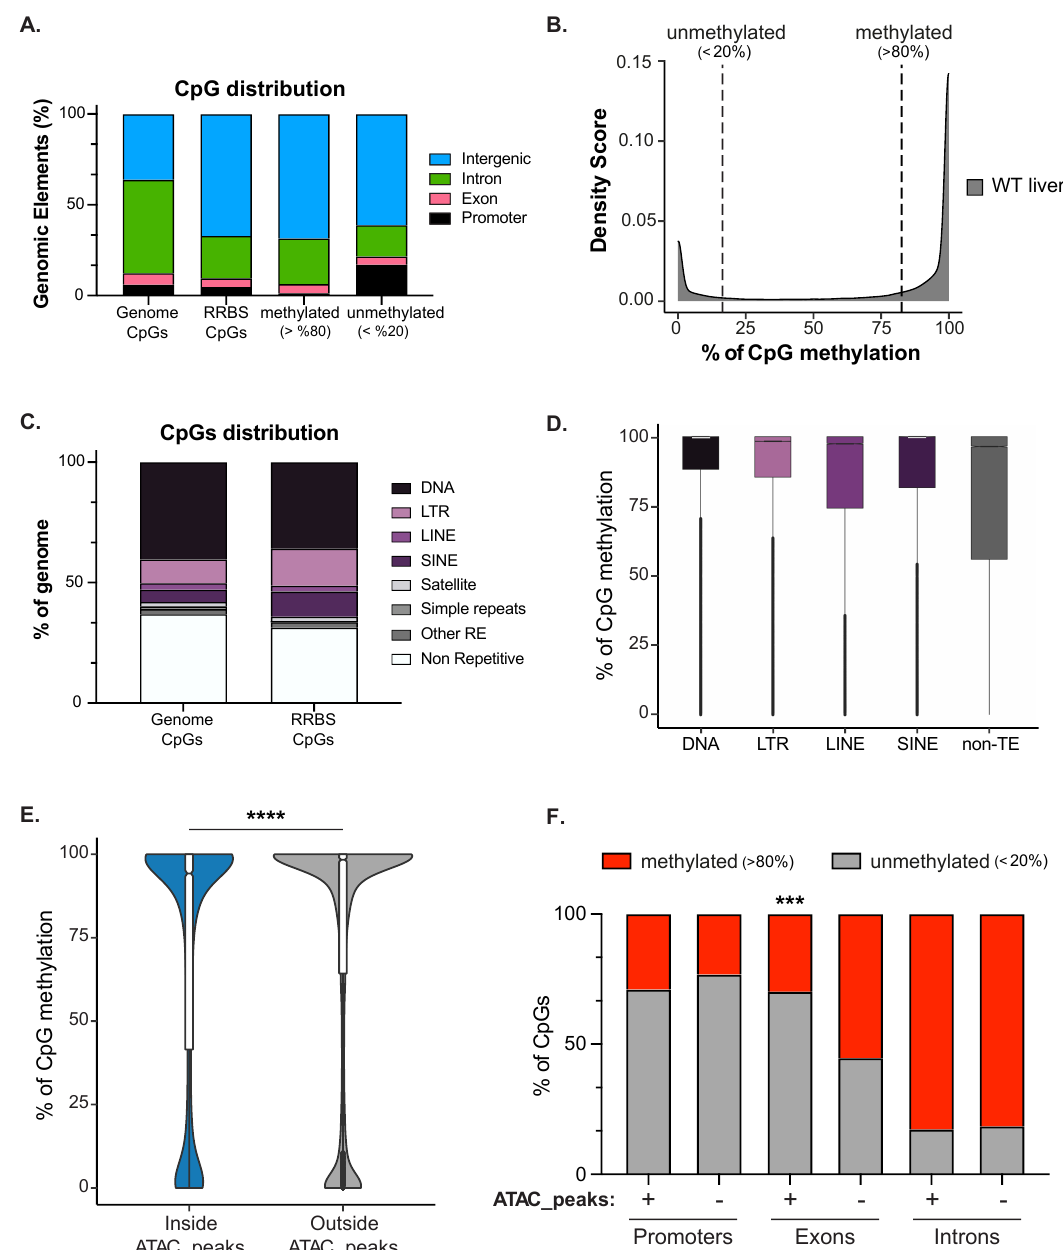
Figure 3. DNA methylation is enriched in the intergenome and on transposons. ( A ). RRBS Genomic Annotation on 120 hpf zebrafish livers of the CpGs common to the unified dataset of 3 biological replicates from 120 WT zebrafish larvae (2,173,502 CpGs). CpGs were categorized as methylated (>80%; 1,521,222 CpGs) and unmethylated (<20%; 427,492 of CpGs) and then were classified based on annotated genomic elements. The distribution of CpGs in the whole genome is plotted as a comparison. ( B ). Density plot showing the distribution of CpGs based on methylation level. ( C ). Annotation of CpGs contained in the Repetitive Elements (REs) or not-RE in zebrafish genome and RRBS dataset. ( D ). Box plot displaying the percent of methylation of CpGs contained in each Class of Transposable Elements (TEs) and not-TEs. ( E ). Violin plot displays the percent of CpG methylation in zebrafish livers contained inside (blue) or outside (grey) ATAC-Seq peaks. An equal number of CpGs (11,034 CpGs) contained outside of ATAC-seq peaks were randomly selected for comparison. **** indicates p -value < 0.0001 calculated by unpaired non-parametric Mann–Whitney test. ( F ). Box plot displaying the percent of CpGs either methylated (red, >80%) or not-methylated (grey, <20%) in WT livers: From left, CpGs contained inside (represented with +) or outside (represented with − ) of ATAC-Seq peaks classified based on their location in annotated genomic element (promoters, exons, and introns). p -values were calculated by unpaired non-parametric multiple comparisons Kruskal-Wallis test. *** means p -value <